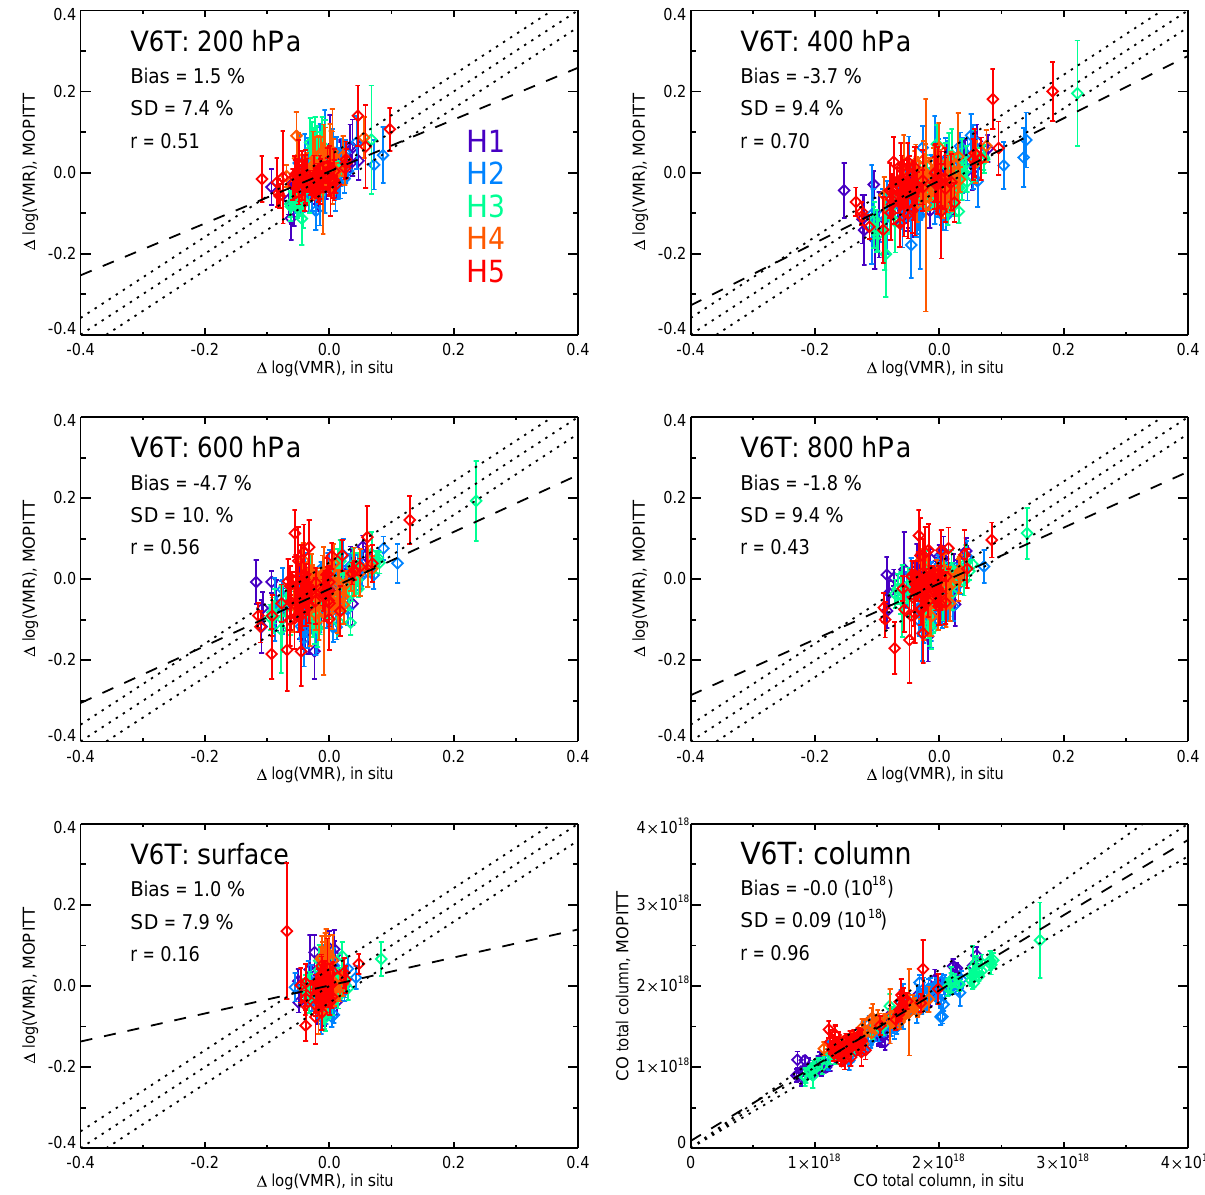
Figure 9. V6 TIR-only validation results based on the HIPPO in situ profiles. Results for phase 1 (H1), phase 2 (H2) etc. are identified by color. See caption to Fig.